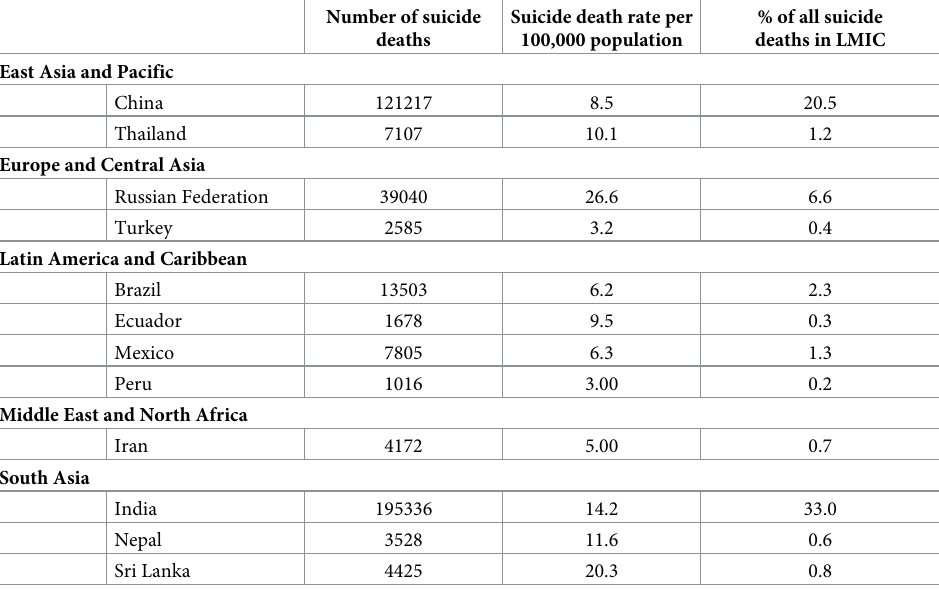
Table 1. Number of suicide deaths and rate of suicide deaths in 2019 for countries included in review, the global burden of disease study 2019